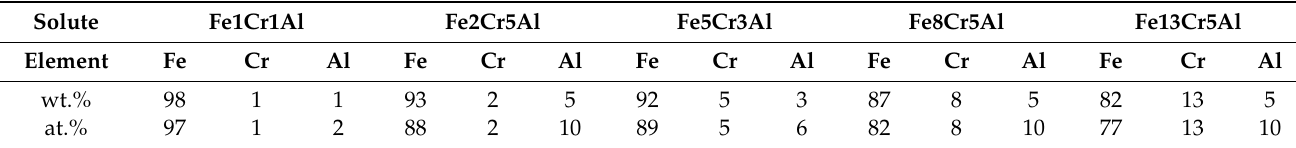
Table 1. Examples of conversion from wt.% to at.% for several FeCrAl